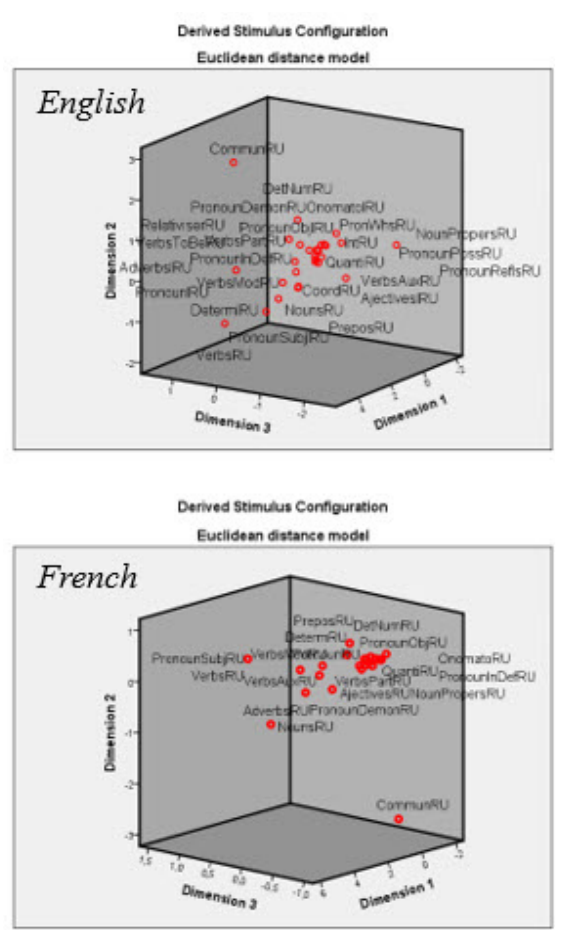
Figure 6. Euclidian distance model after multidimensional scaling of the POS RU